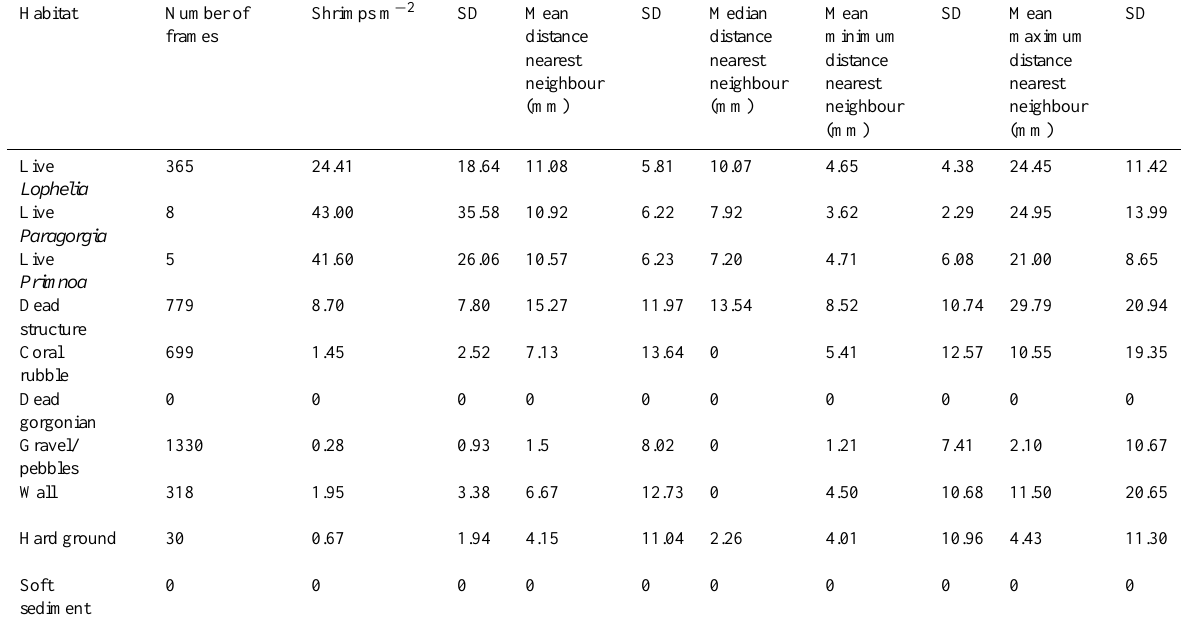
Table 1. Shrimp densities observed across the various habitat categories. Mean and median distance between individual shrimp observed in association with each habitat category are also given. Mean minimum and maximum distances between nearest neighbours are also shown.